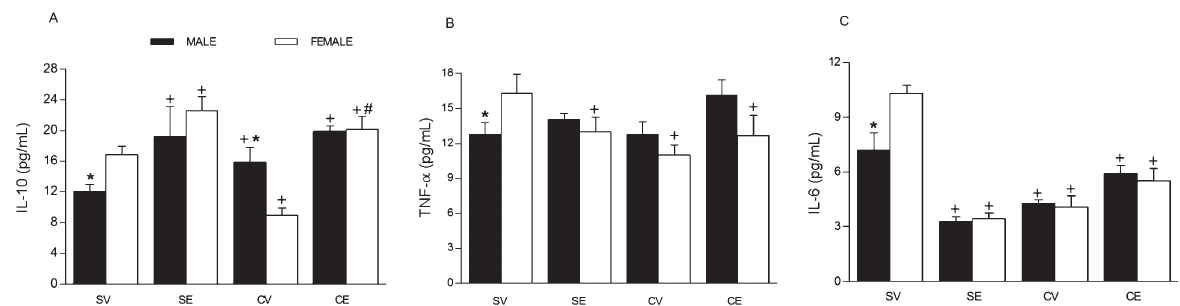
Figure 2. Cytokine levels. A , IL-10, B , TNF- a , and C , IL-6 levels of SV (sham + vehicle), SE (sham + enalapril), CV (castrated + vehicle), and CE (castrated + enalapril) groups, as measured by ELISA. Data are reported as means ± SE. *P , 0.05 vs females of the same group; + P , 0.05 vs sham vehicle animals of the same sex; # P , 0.05 vs castrated animals of the same sex (two-way ANOVA and Fisher